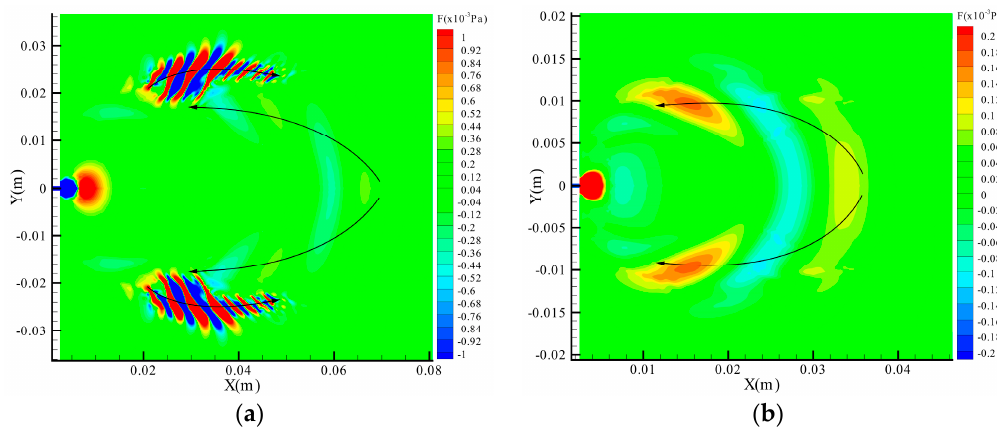
Figure 10. Pressure fluctuation contour of different leak hole diameter (The arrow marked in the figure represents the direction of fluctuation wave propagation.). ( a ) 1 mm; ( b ) 0.5 mm.